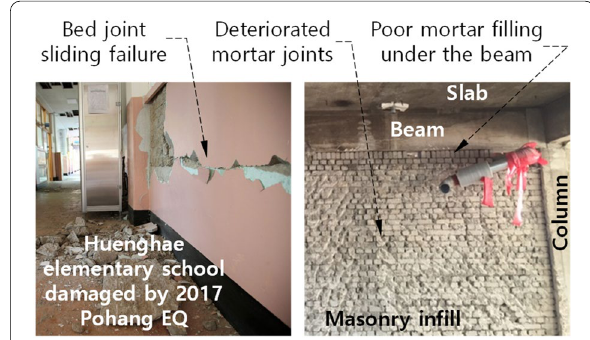
Fig. 1 Reinforced concrete frames with masonry infills.